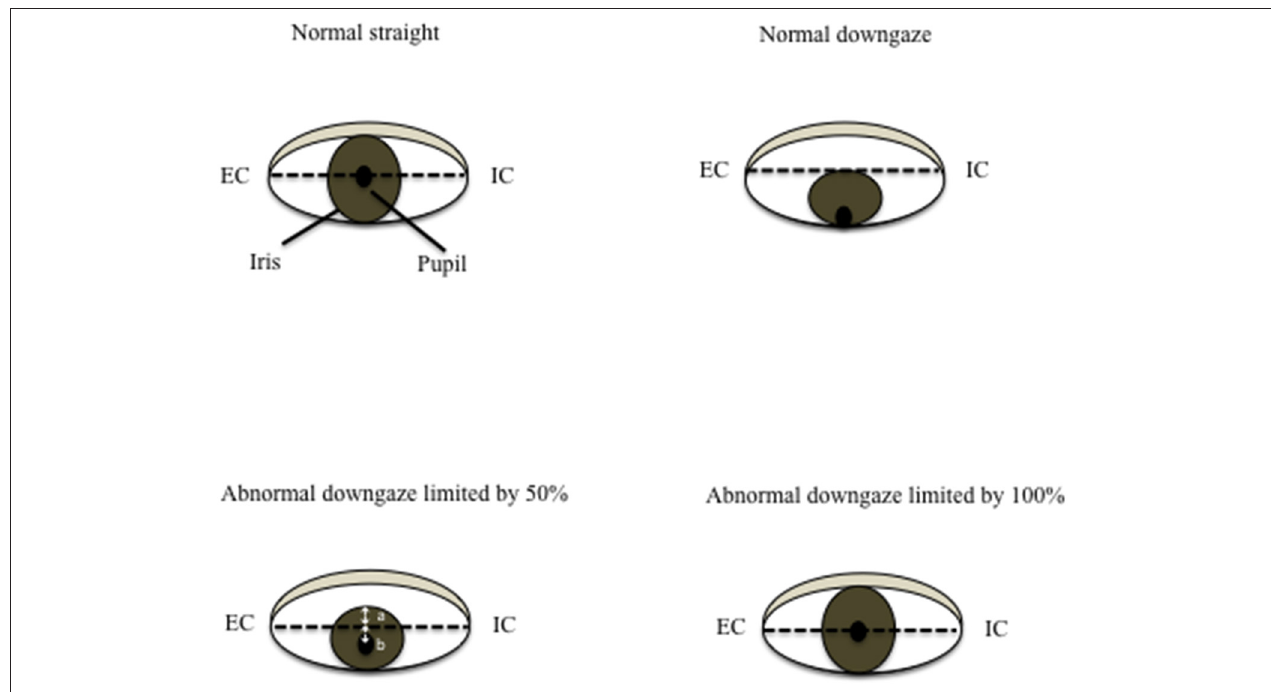
FIGURE 1 | Measurement of downgaze palsy in principle. The severity of downgaze palsy is (a/r) × 100% or [a/(a + b)] × 100%. r, radius of the iris (r = a + b); EC, external canthus; IC, internal